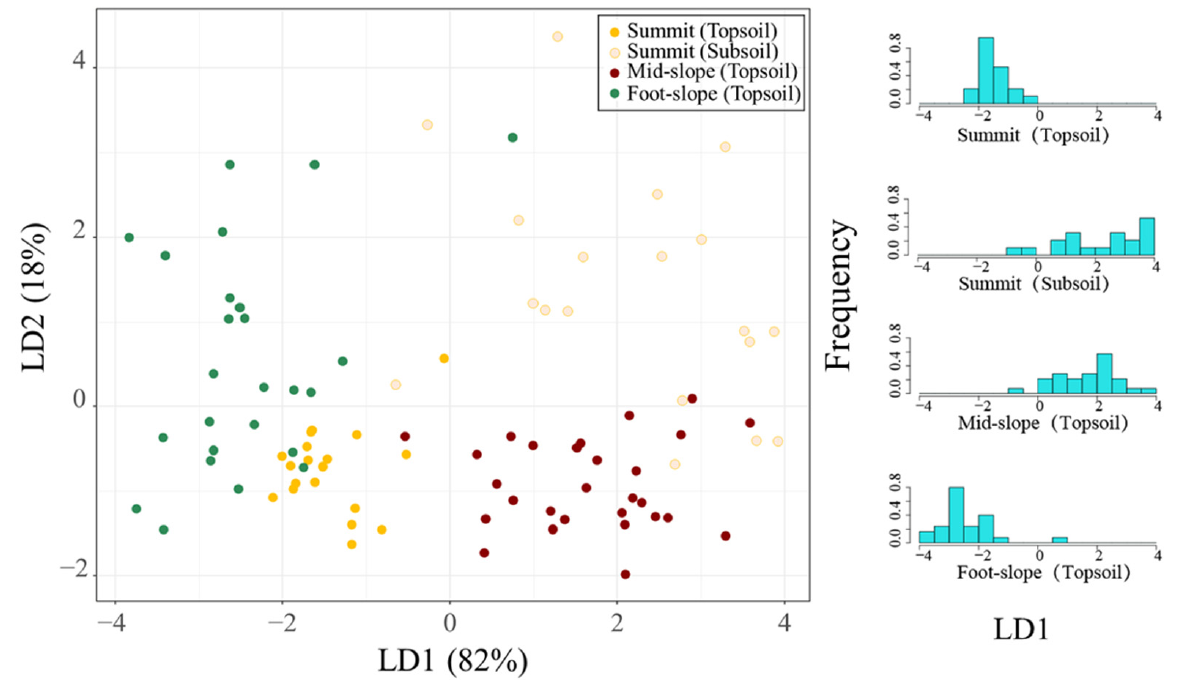
Figure 3. Classification of three slope positions based on linear discriminant analysis (LDA) of PC scores arising from laboratory-based VNIR spectra. Subsoil spectra of Summit positions were included to investigate any spectral similarity to the topsoil of Mid-slope positions. Histograms on the right show the distribution of the first LD function’s value for the four sample groups. Table 1. Confusion matrix of laboratory-based spectral classification of erosion intensity using a combination of principal component and linear discriminant analysis (PCA-LDA).